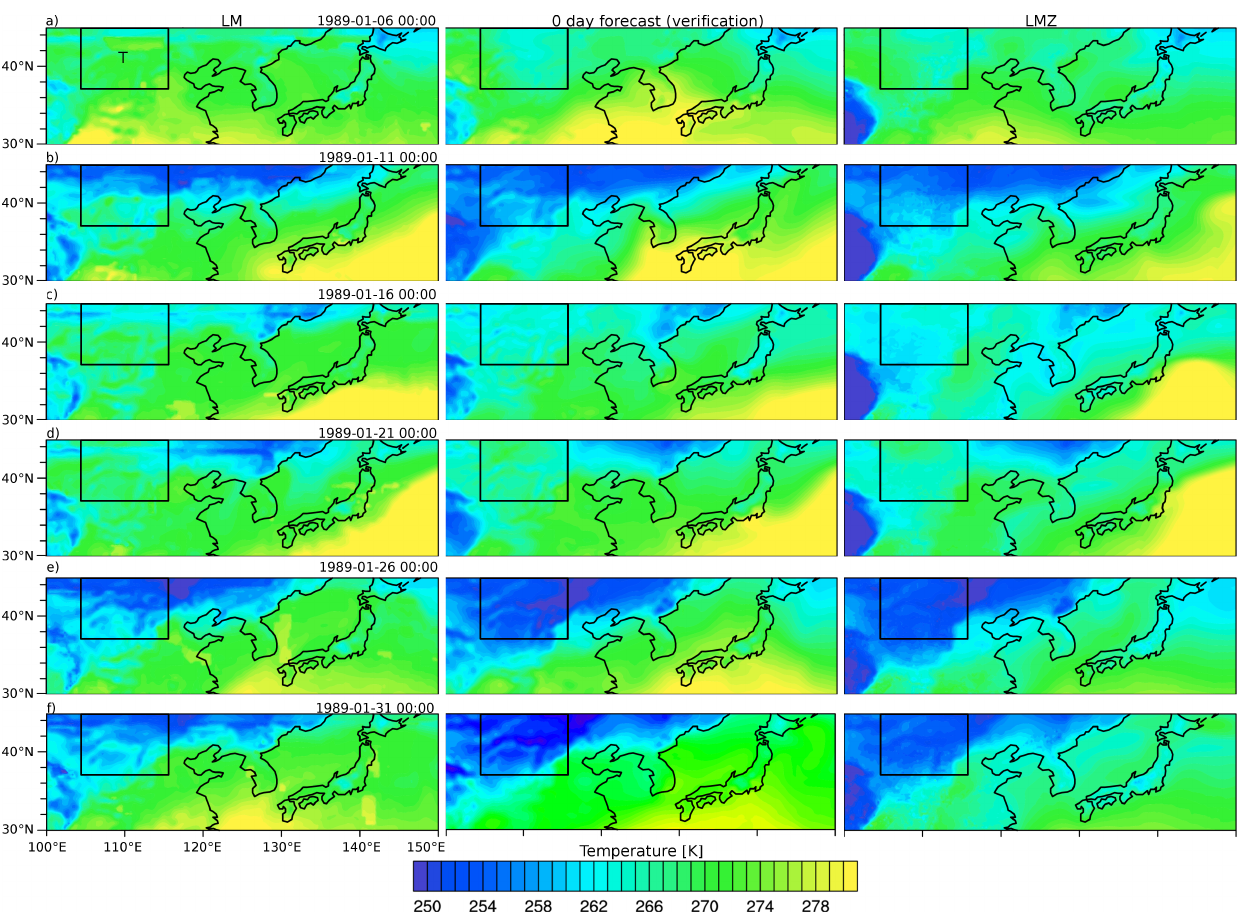
Fig. 2. (a) Temperature for the five-day forecast from 1 January 1989 of level 20 for the terrain-following model LM (left), the cut-cell model LMZ (right) and the zero-day forecast from 6 January 1989 (“verification”, middle); (b–f) as (a) , for dates 6, 11, 16, 21, 26 January. The black box in the top left corner denotes the area ( T ) used to calculate the temperature biases.